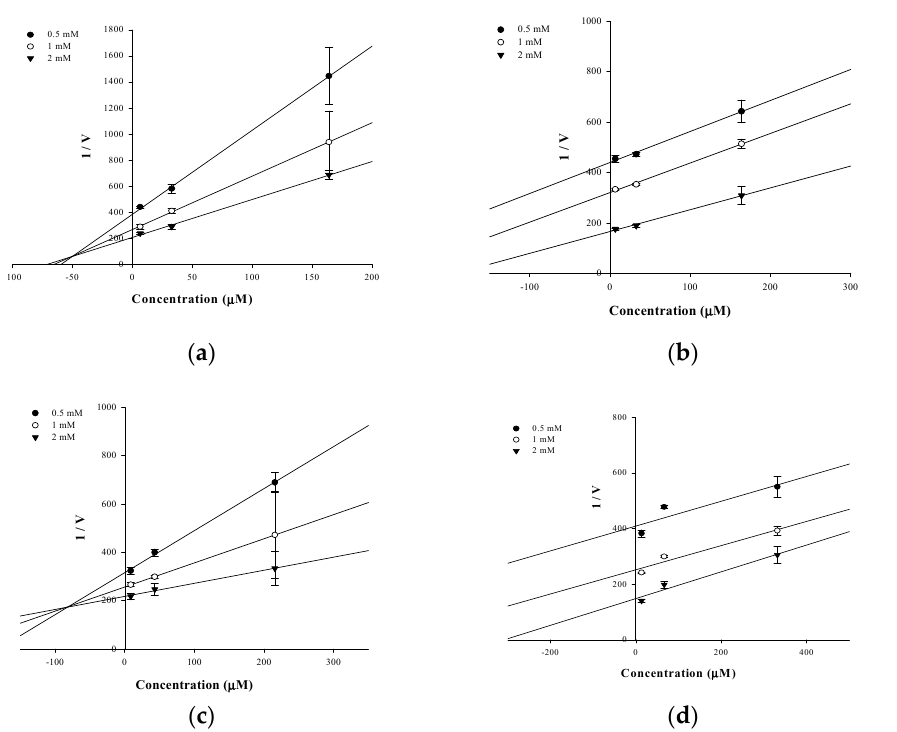
Figure 2. Dixon-plots of the inhibition of PTP1B by the compounds. The results showed the effects of the presence of di ff erent concentrations of the substrate (0.5 mM ( ● ), 1 mM ( ○ ) and 2 mM ( ▼ ) for hesperidin ( a ), neohesperidin ( b ), hesperetin 5- O -glucoside ( c ) and hesperetin ( d ).